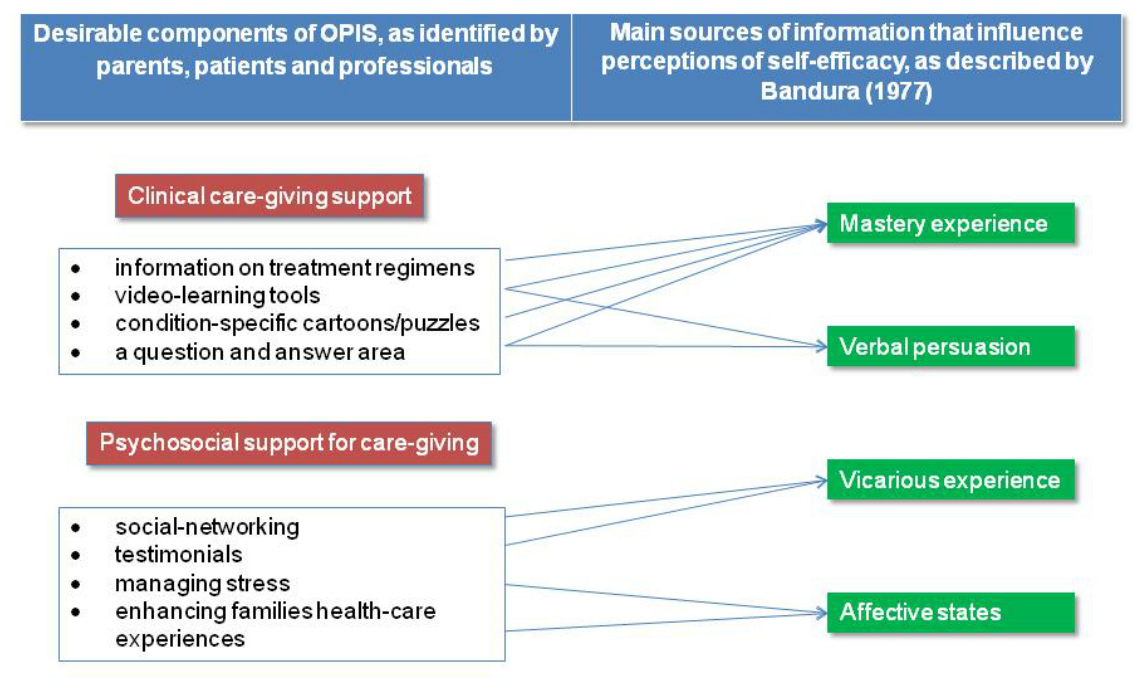
Figure 1. Online Parent Empowerment Model in CKD management